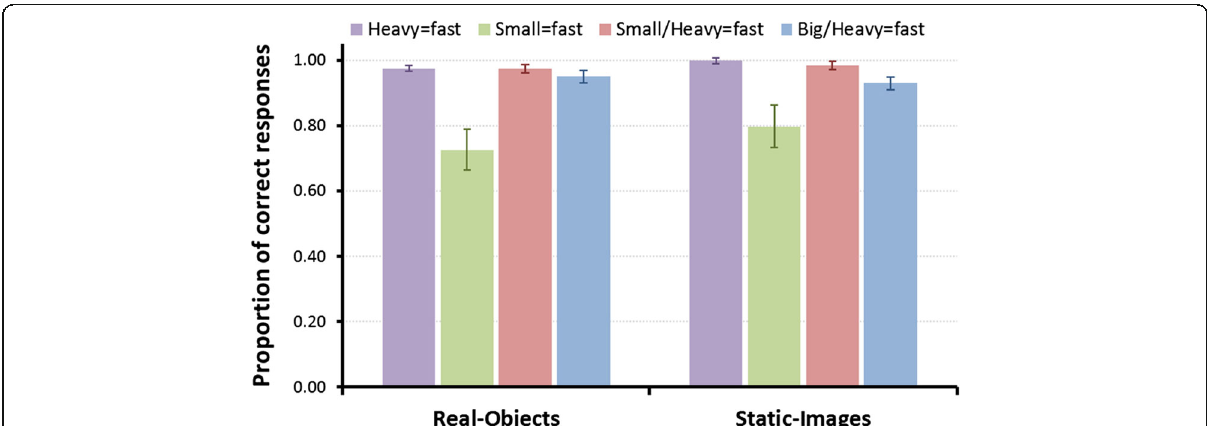
Fig. 5 Average proportion of correct answers in Experiment 1, separated by condition and trial type (see Fig. 1 for an example of each trial type). Trials differ in whether the faster object in a pair was heavy (heavy = fast), small (small = fast), small and heavy (small/heavy = fast), or big and heavy (big/heavy = fast). A mixed-design condition-by-trial analysis of variance (ANOVA) revealed a main effect of trial type. Specifically, we found